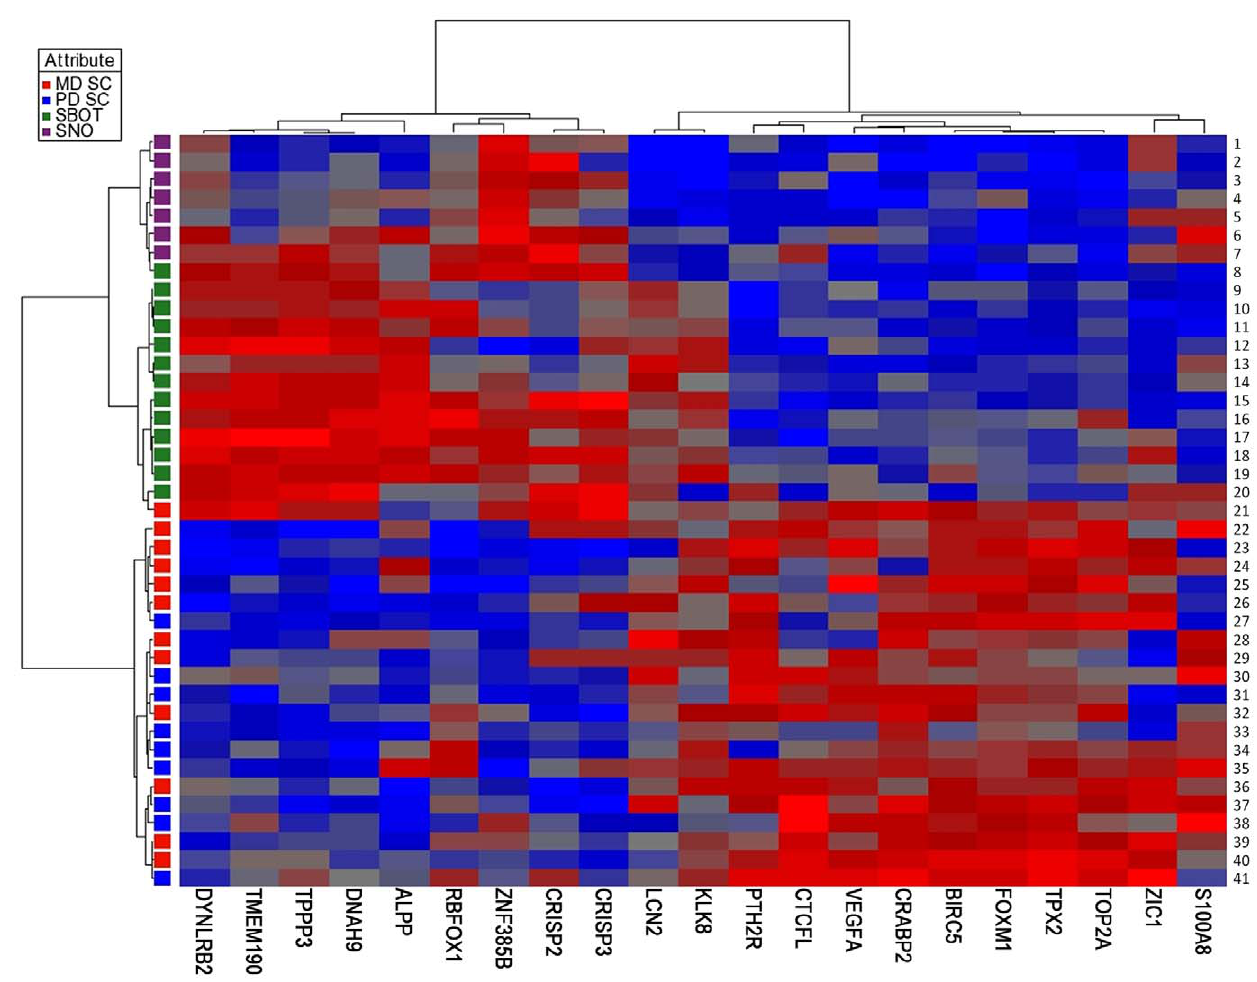
Figure 1. Cluster analysis heatmap. Cluster analysis heatmap of the expression levels ( D Cq values) of 21 differentially expressed mRNAs (p , 0.01) in moderately (MD) and poorly differentiated (PD) serous ovarian carcinomas (SC), serous ovarian borderline tumours (SBOT) and superficial scrapings from normal ovaries (SNO). Each column represents an mRNA and each row a sample. The more over-and under-expressed the mRNA, the brighter the red and blue colour, respectively. Due to technical analysis errors for DYNLRB2, CRABP2, CRISP2, CRISP3 and LCN2 in sample nr 7, 21 and 26, these values are calculated as the mean D Cq values of each subgroup. Further abbreviations are given in Table 3.